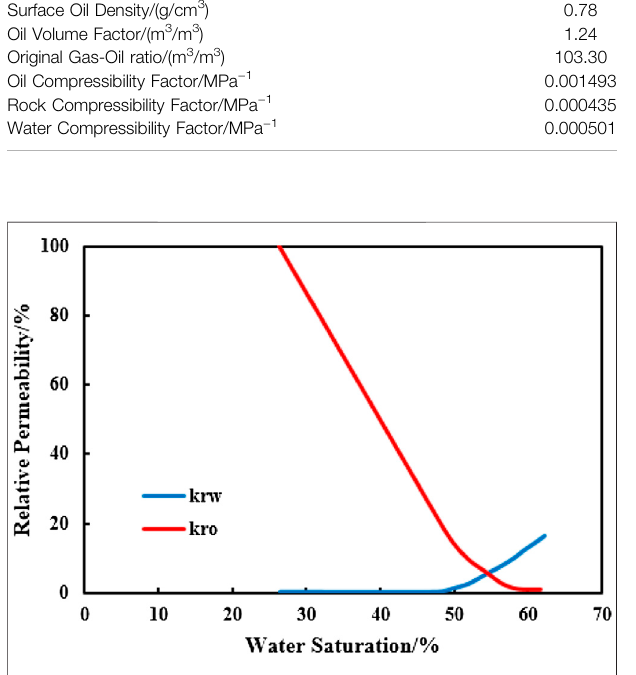
FIGURE2| Relative permeability curve ofdepleteddevelopmentmodel.